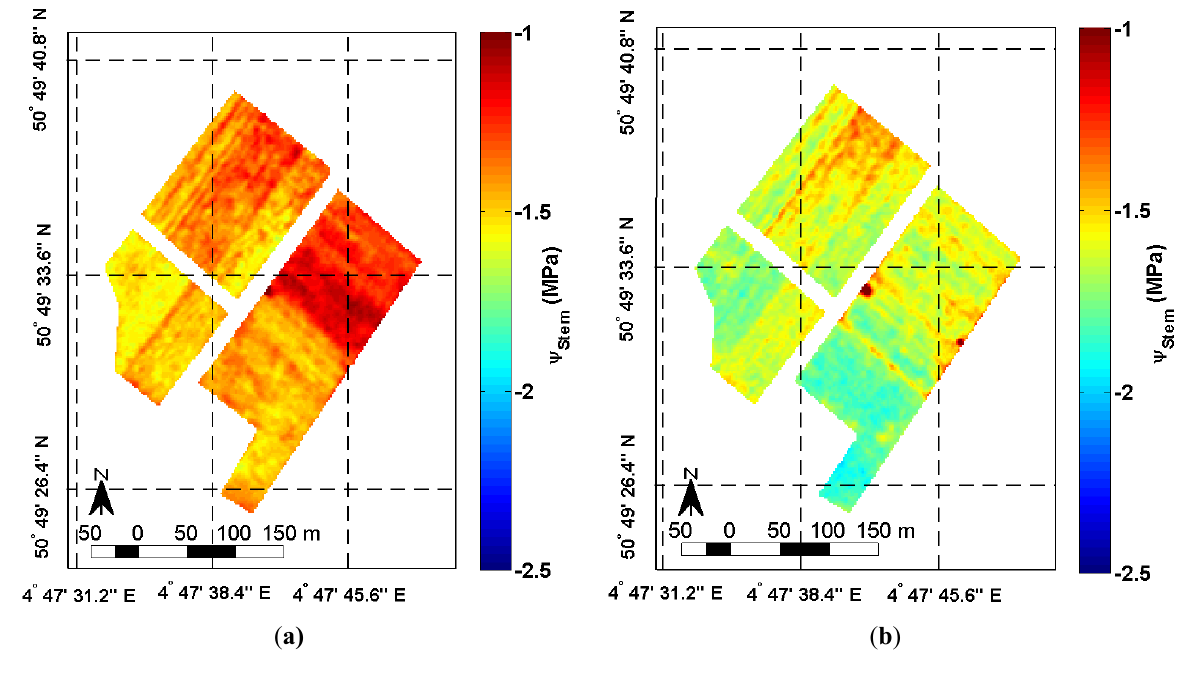
) map (MPa) of the (deficit) irrigated orchard based Figure 7. Stem water potential ( Ψ stem on the correlation depicted in Figure 4 (R 2 = 0.47; RMSE = 0.36 MPa), for the image taken in 2012 on Day Of the Year (DOY) 232 ( a ) and the image taken in 2013 on DOY 189 ( b ) Based on the correlation between satellite derived Red edge Normalized Difference Vegetation Index (ReNDVI, Equation (4)) and measured Ψ (R 2 = 0.47; RMSE = 0.36 MPa; stem map was derived. To avoid effects related to the canopy discontinuity, as Figure 4), a Ψ stem a result of the alternation between canopies, shadows and grasses, a 3 × 3 pixel moving-average filter was applied. The filtering operation smoothed the image and facilitated visual interpretation, in similar fashion to